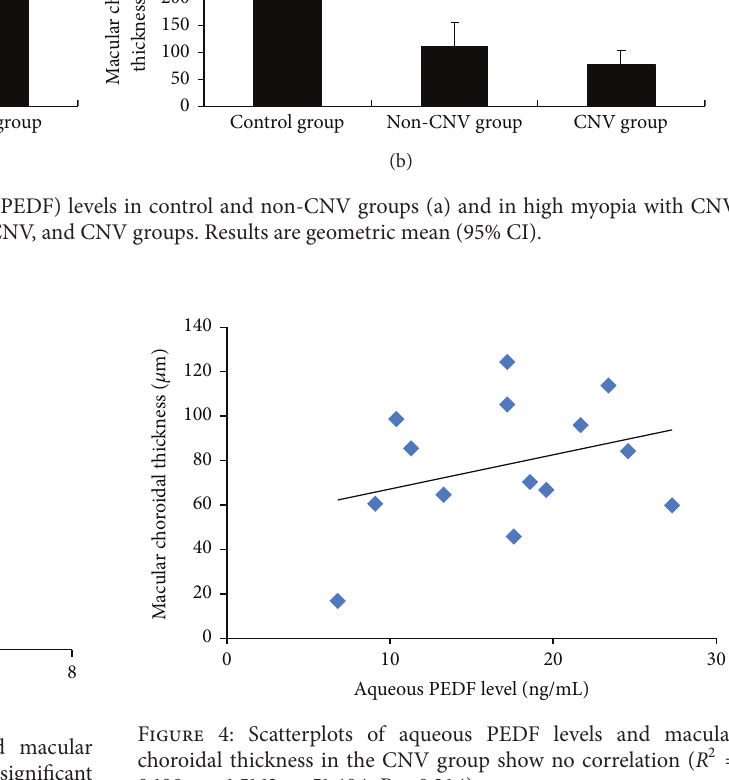
thickness was detected for the non-CNV and CNV groups ( R 2 = 0.078, 𝑃 0.674 ; R 2 = 0.0064, 𝑃 = 0.720 ,